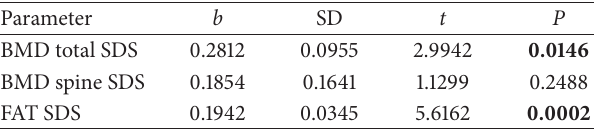
Table 9: Stepwise forward regression model for BMI value.